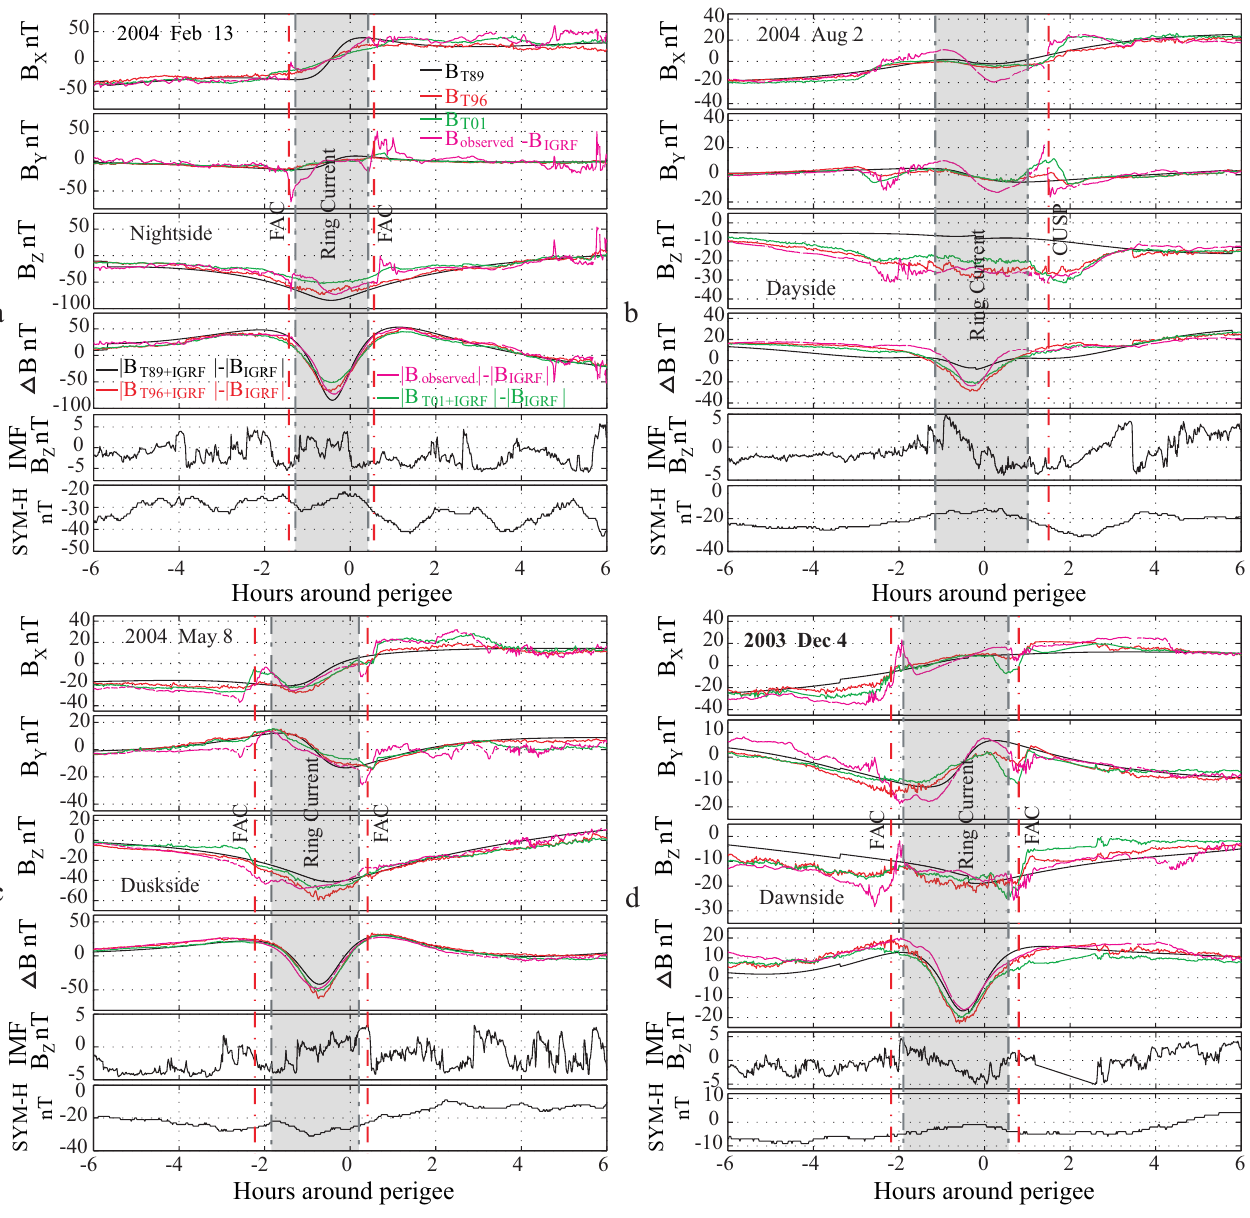
Fig. 2. External magnetic field predicted by T89 (black), T96 (red) and T01 (green) models and measured by Cluster S/C 1 (the observations minus the predictions from IGRF model, magenta) at the tracks of Cluster S/C 1 on 13 February 2004 (a) , 2 August 2004 (b) , 8 May 2004 (c) and 4 December 2003 (d) , respectively, together with the IMF B Z and SYM-H index. From top to bottom panels in each figure are for the X GSM , Y GSM , Z GSM and the magnitude of the field. The black vertical dashed lines show the ring current region crossing.